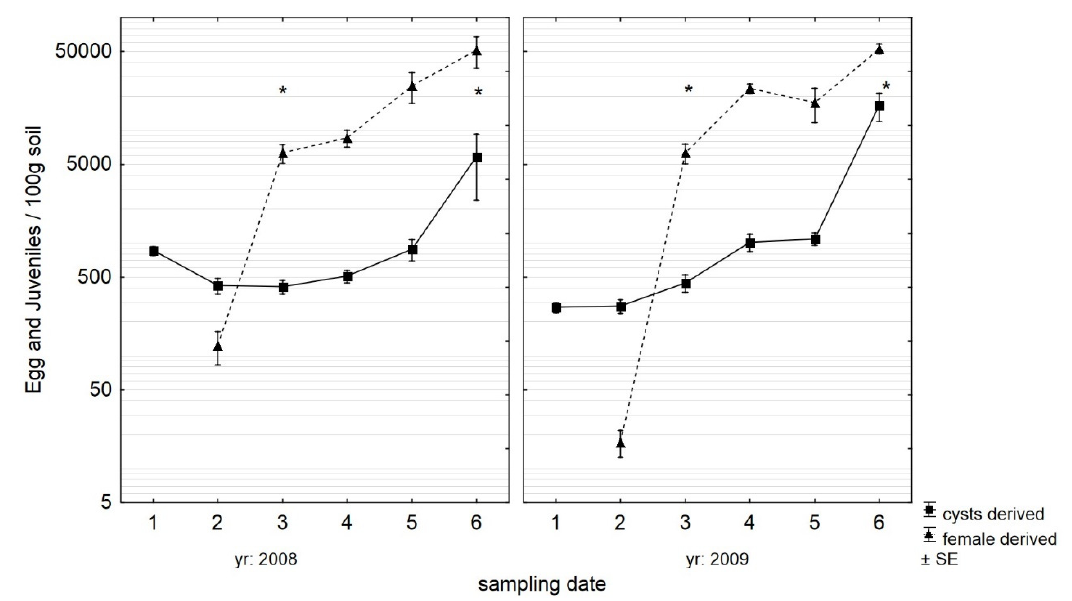
Figure 2. Population dynamics of beet cyst nematode (BCN) eggs and juveniles per 100 g of soil extracted from mature cyst and females separately from pots with oilseed rape (OSR) plants at six sampling dates after sowing referring to degree days ( > 8 ◦ C) in the year 2008: 135 DD, (date 1), 225, (2), 324, (3), 396, (4), 441, (5), 522, (6) and in the year 2009: 123, (1), 199, (2), 318, (3), 405, (4), 456, (5), 550,